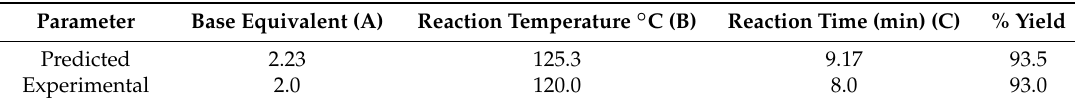
Table 5. Model validation for metal free reaction.